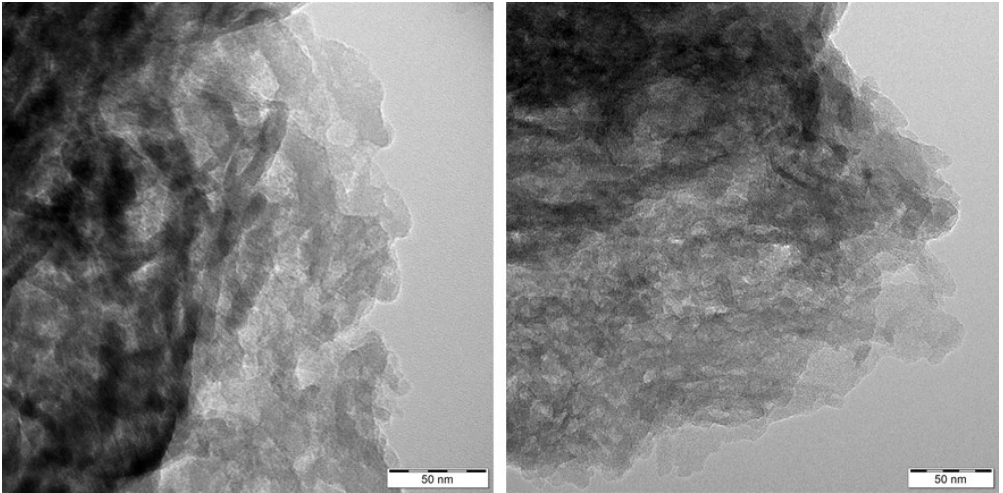
Figure 11. TEM images of Ex3 ( left ) and Ex3 30 % H 2 O 2 nanomaterials ( right ).